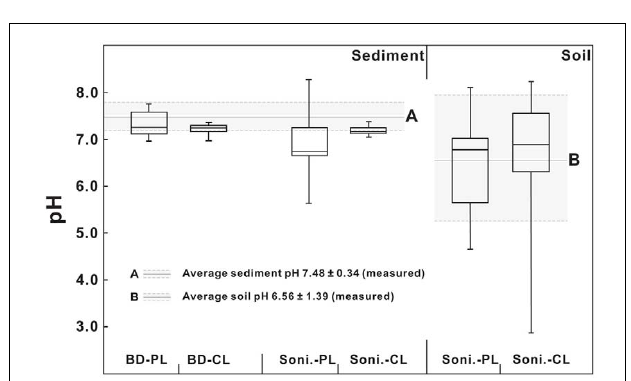
FIGURE 7 | Comparison of CBT-derived pH to measured pH values of soil and sediments for the sonication (Soni) and Bligh and Dyer (BD) methods. CL, core lipids; PL, polar